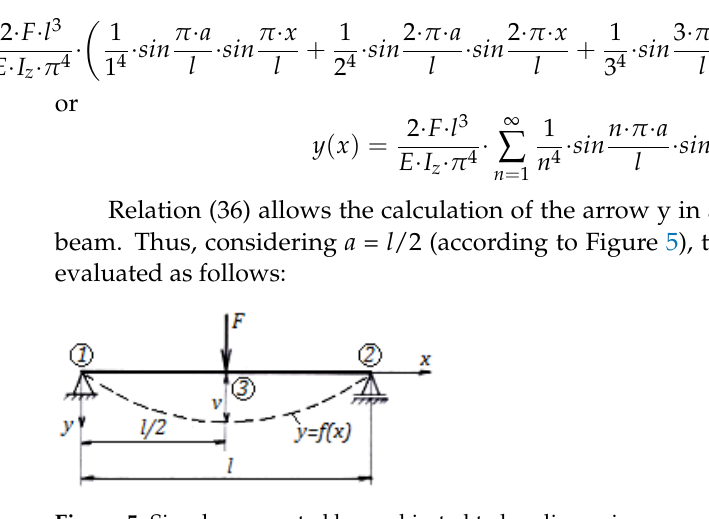
Figure 5. Simply supported bar, subjected to bending using a concentrated force, F .